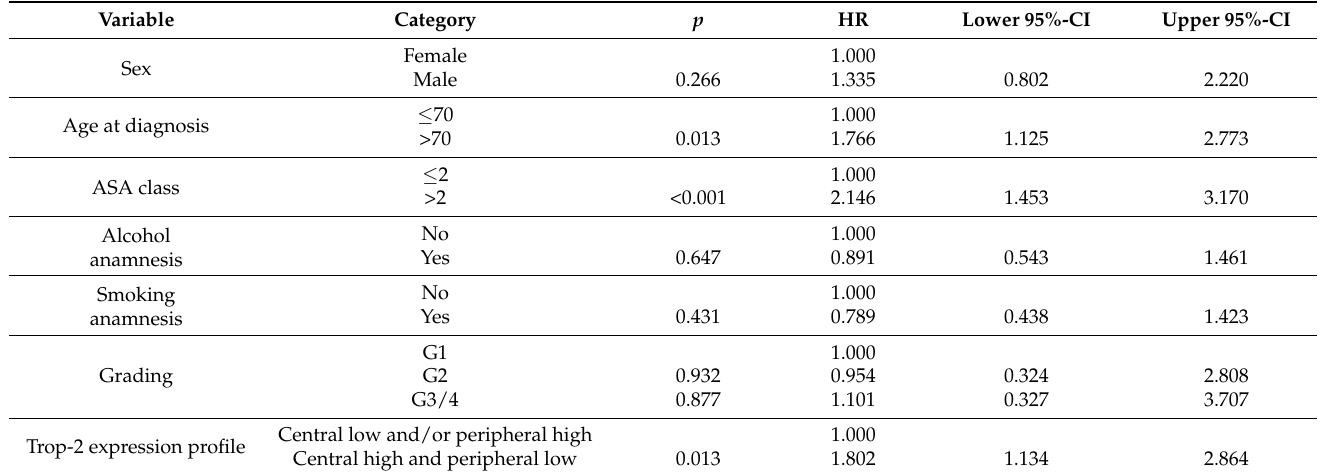
Table 2. Multivariate Cox regression for Trop-2 central high and peripheral low as well as prognostic factors on OS ( n = 160). UICC 7th edition.